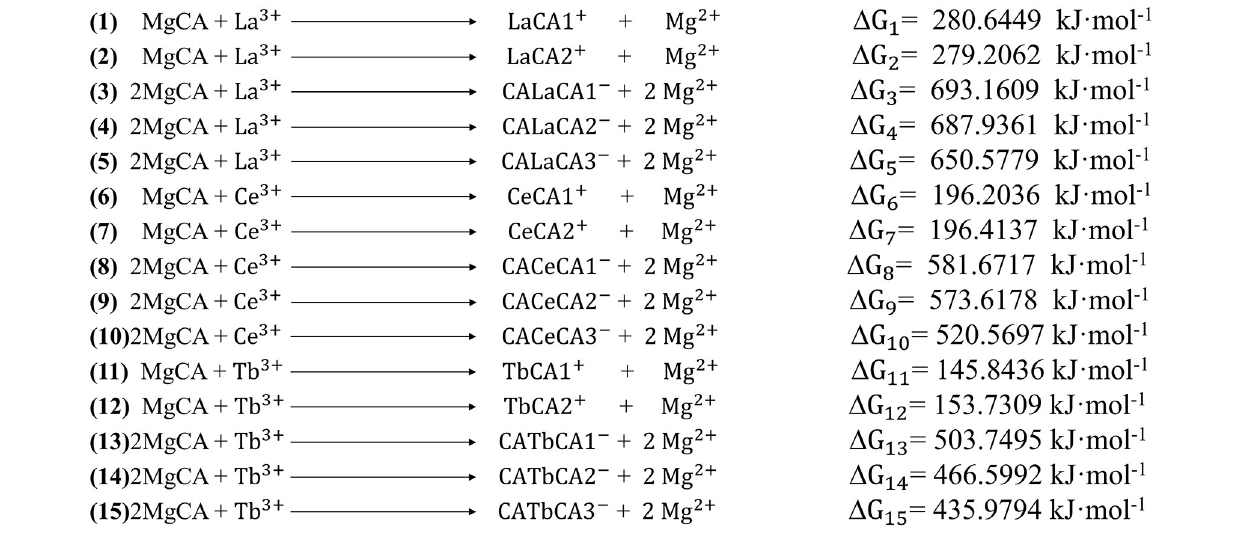
FIGURE 5 | The changes in Gibbs free energy for the 15 possible reactions.